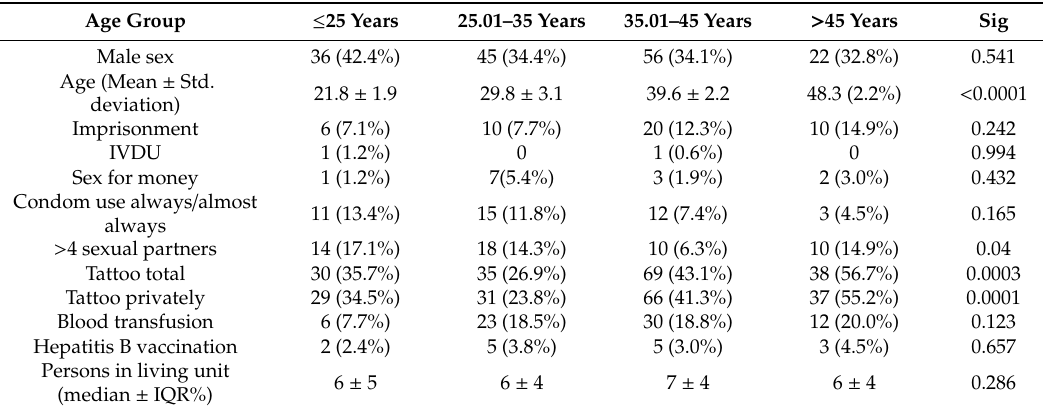
Table 3. Characterisation of individual age